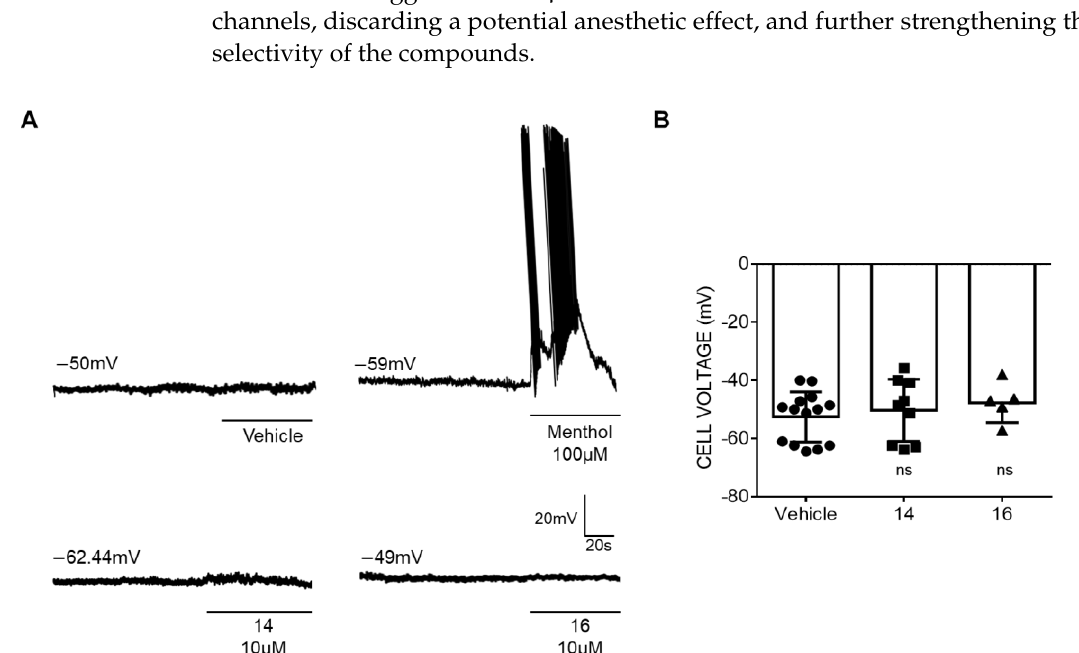
Figure 3. Compounds 14 and 16 do not affect the membrane resting potential of sensory neurons. ( A ) Representatives recordings of resting membrane potential measured under current-clamp configuration. The upper traces show the action potentials (APs) firings from the dorsal root ganglion (DRG) neuron elicited by 100 µ M menthol and the lower traces show the voltage membrane in the presence of the β -lactams derivatives. ( B ) Changes in Vm in the absence and in the presence of 10 µ M of compound 14 or 16 were analyzed by t-test, ns—no significance. Compounds were used at 10 µ M. Data are given as means ± SEM; n ≥ 10 cells.